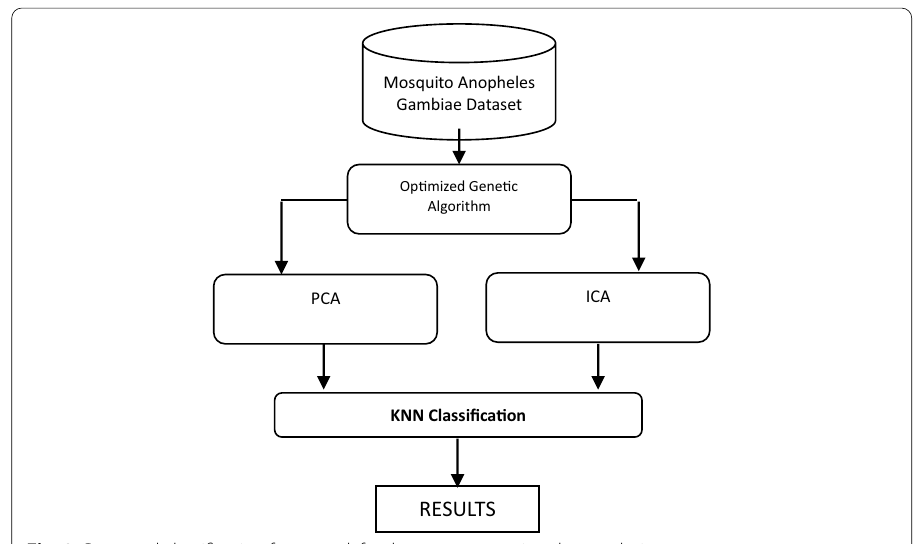
Fig. 2 Proposed classification framework for the gene expression data